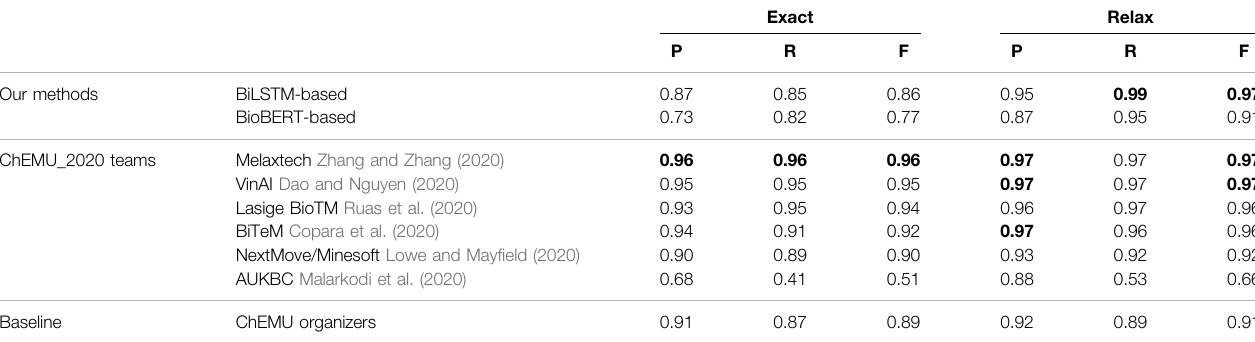
Bold indicates best results for P, R, and F for both exact and relax match